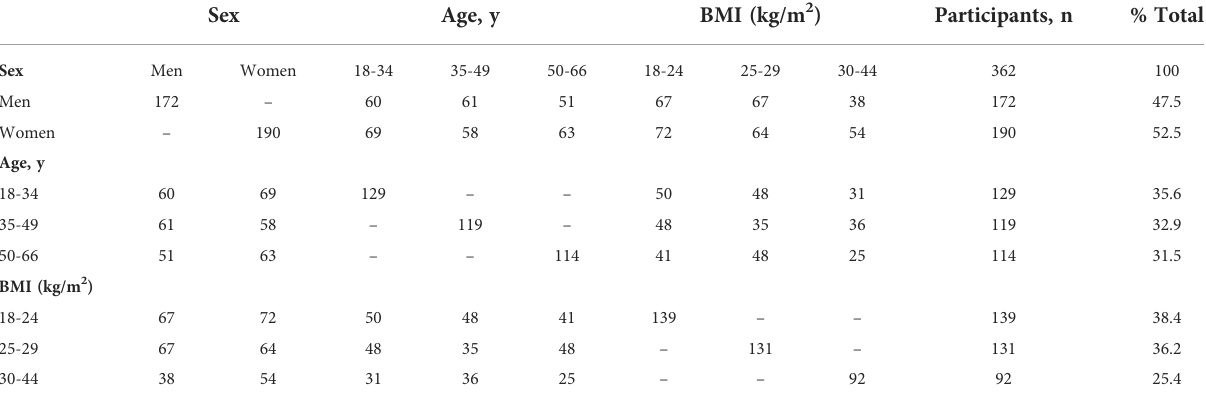
TABLE 1 Characteristics of healthy adult participants who provided fasting blood